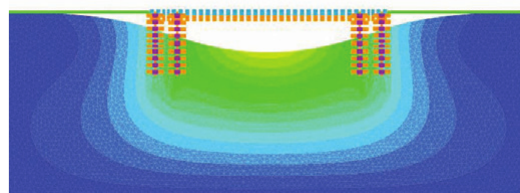
fig. 7. A deformable view of soil for the piled raft variant II of the plane numerical